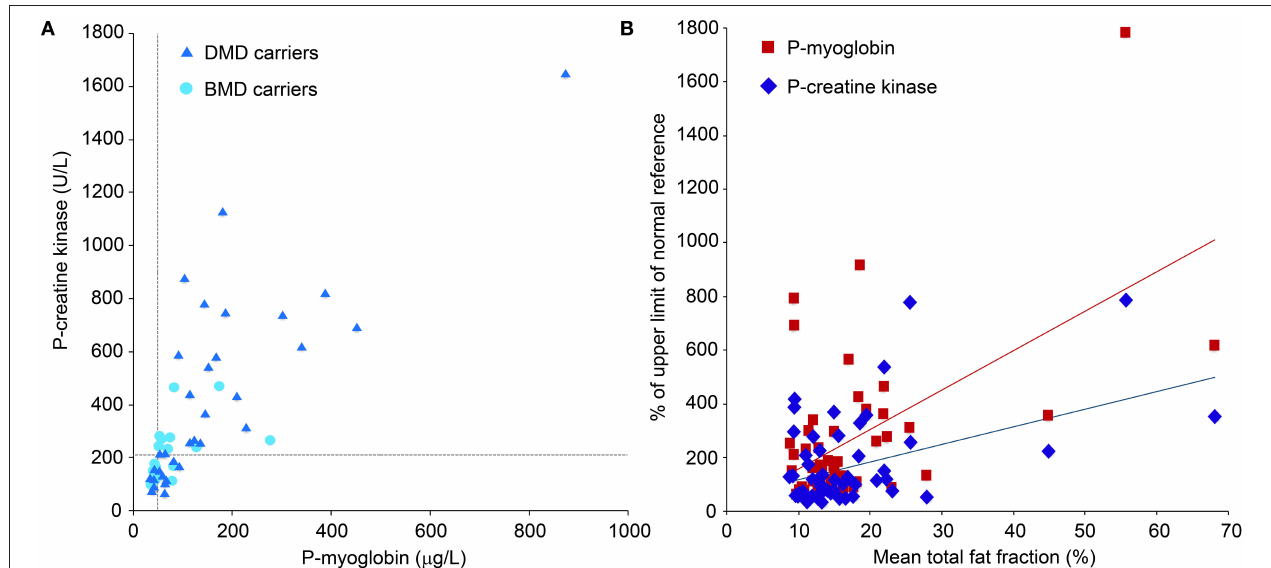
FIGURE 5 | Biomarkers. Plasma creatine kinase (CK) and myoglobin levels from blood samples in women with pathogenic variants in the DMD gene predicted to cause Duchenne muscular dystrophy (DMD) and Becker muscular dystrophy (BMD). Reference cutoffs are marked with light blue lines (A) . Normal CK reference level 35–210 U/l, normal myoglobin reference level 19–49 µ g/L. (B) shows the correlation between mean lower-extremity fat fractions and the two different plasma biomarkers creatine kinase and myoglobin ( R = 0.53 and R = 0.612, respectively; p < 0.001). To be comparable, CK and myoglobin are presented as % of upper limit of